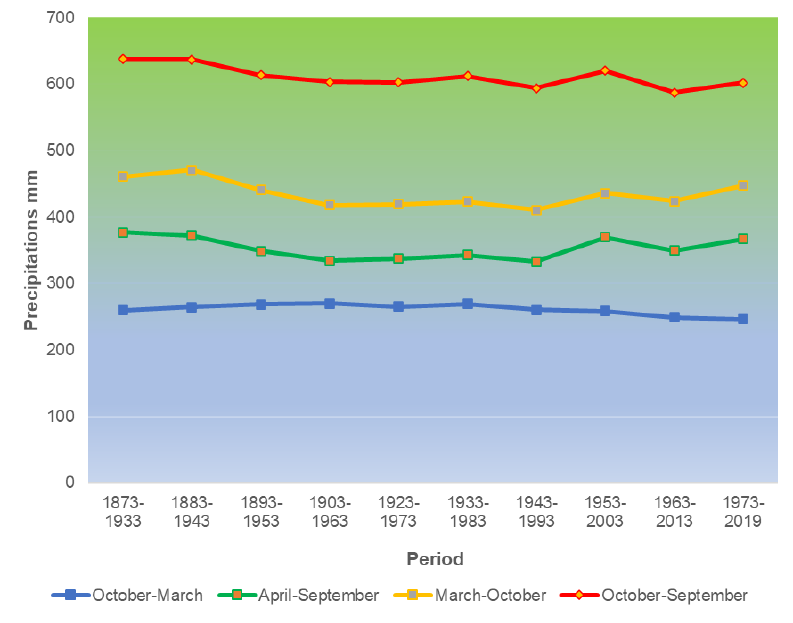
Figure 11. Evolution of rainfall in the Banat Plain represented over periods of 50 years (1873 – 2019).